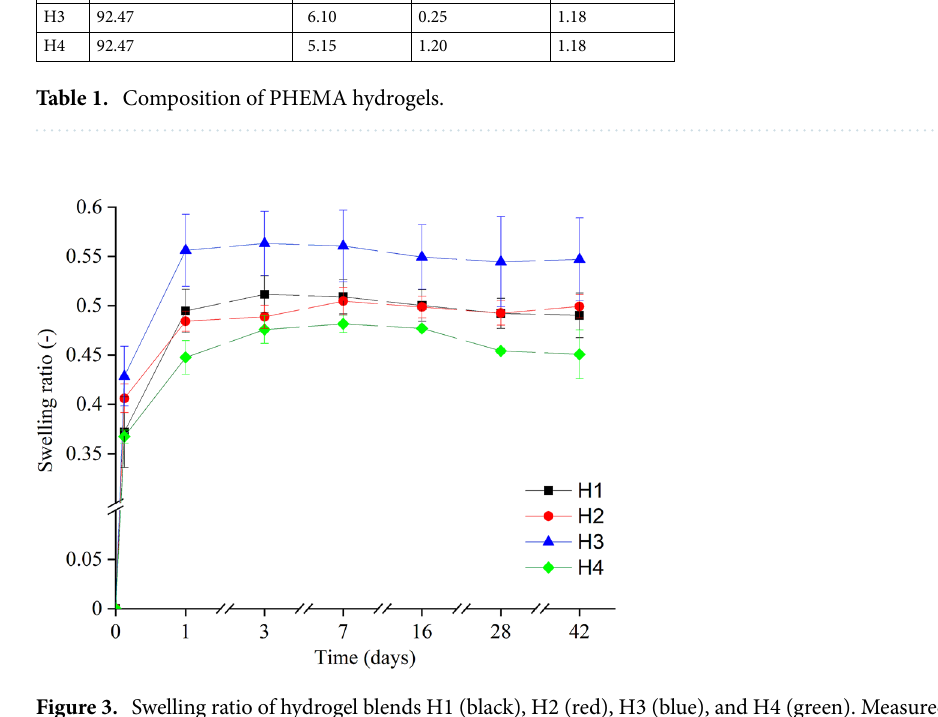
Figure 3. Swelling ratio of hydrogel blends H1 (black), H2 (red), H3 (blue), and H4 (green). Measured points are connected by auxiliary lines to guide the